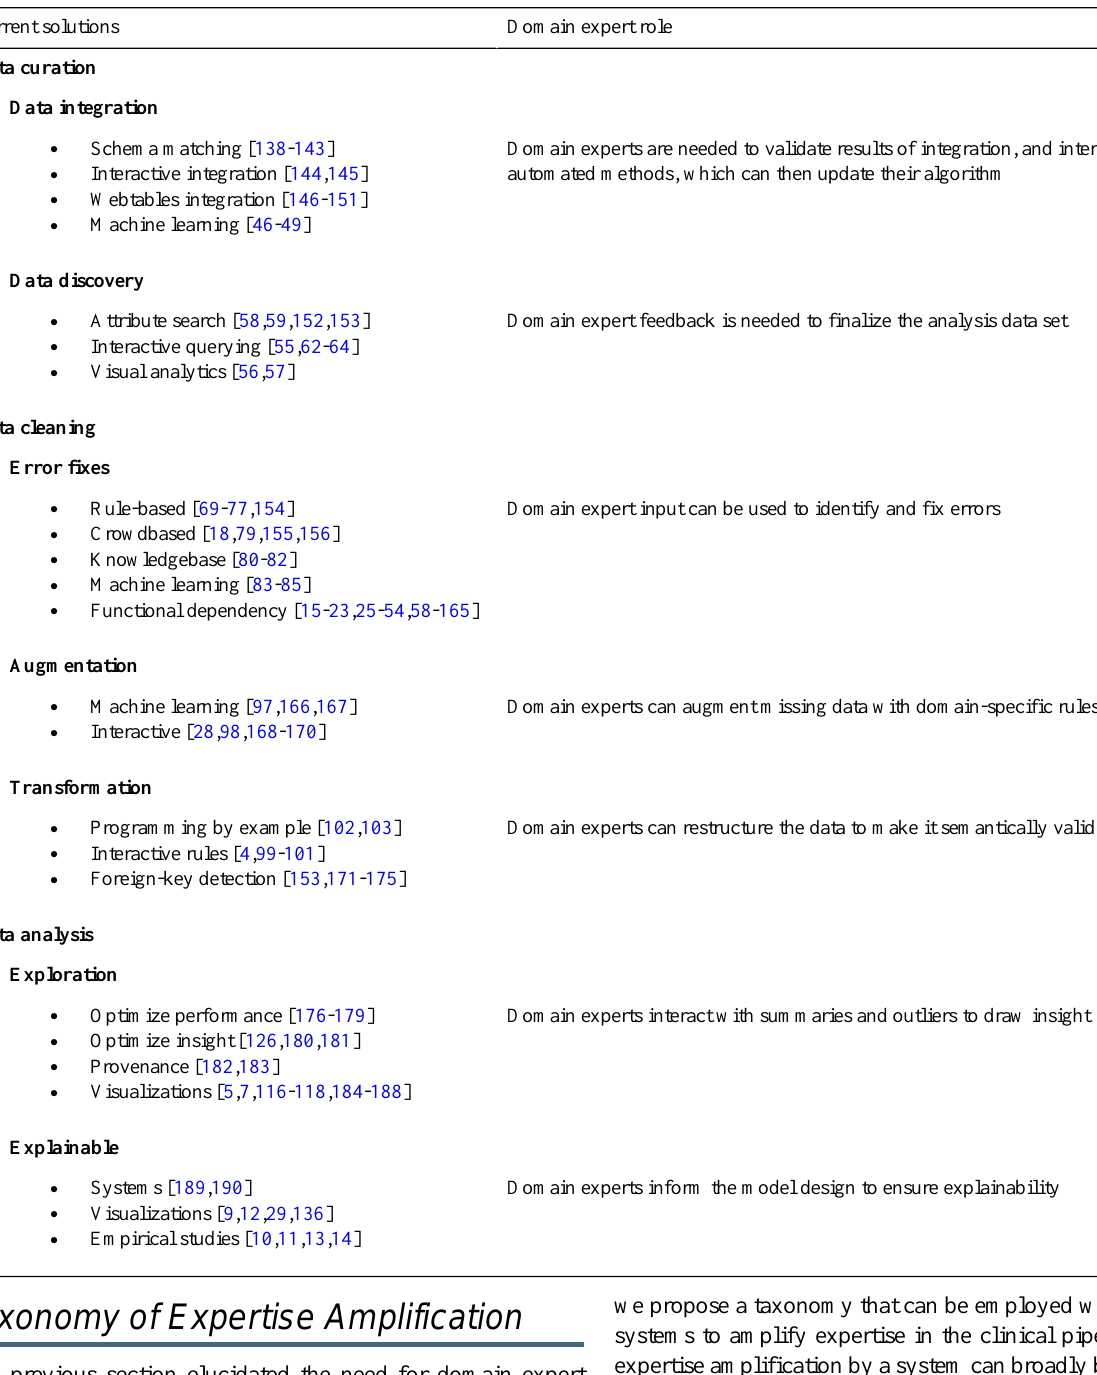
Table 1. Review of current approaches for each data pipeline